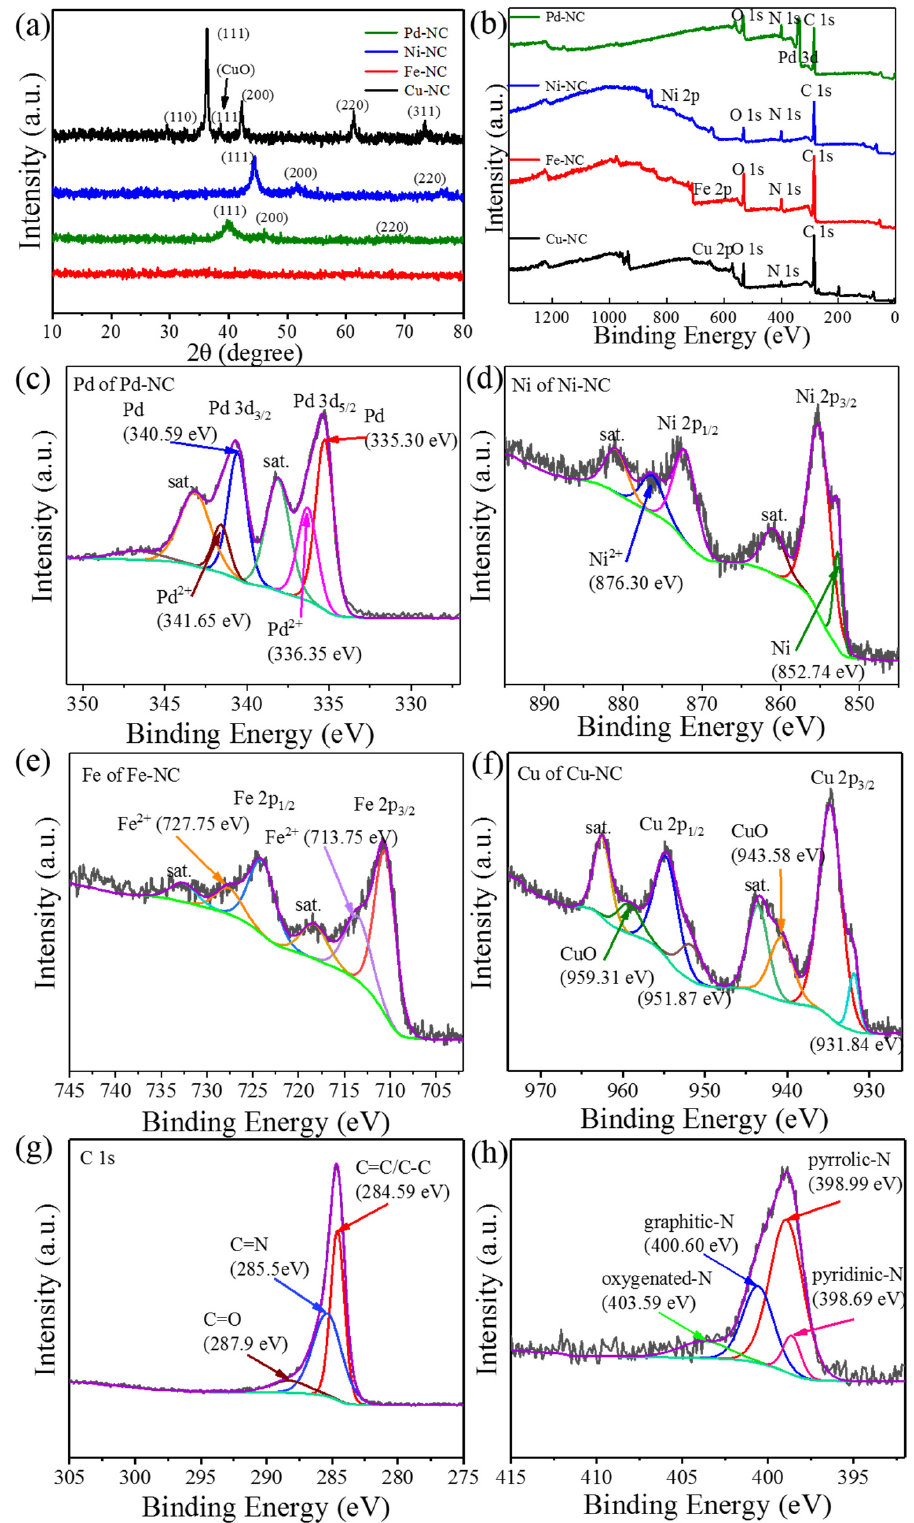
Figure 1. ( a ) XRD patterns of Pd-NC, Ni-NC, Fe-NC, Cu-NC. ( b ) Full spectra of XPS of Pd-NC, Ni-NC, Fe-NC, Cu-NC. High-resolution XPS of Pd of Pd-NC ( c ), Ni of Ni-NC ( d ), Fe of Fe-NC ( e ), Cu of Cu-NC ( f ), C of Pd-NC ( g ), N of Pd-NC ( h ). The XRD patterns in Figure 1a clearly revealed that the diffraction peaks of Cu-NC were corresponding to the indexed Joint Committee on Powder Diffraction Standards (JCPDS) no. 78-2076 of Cu with micro amount of CuO [14]. The XRD patterns of Ni-NC and Pd-NC were indexed to corresponding to no. 04-1043 and 46-1043, which confirmed